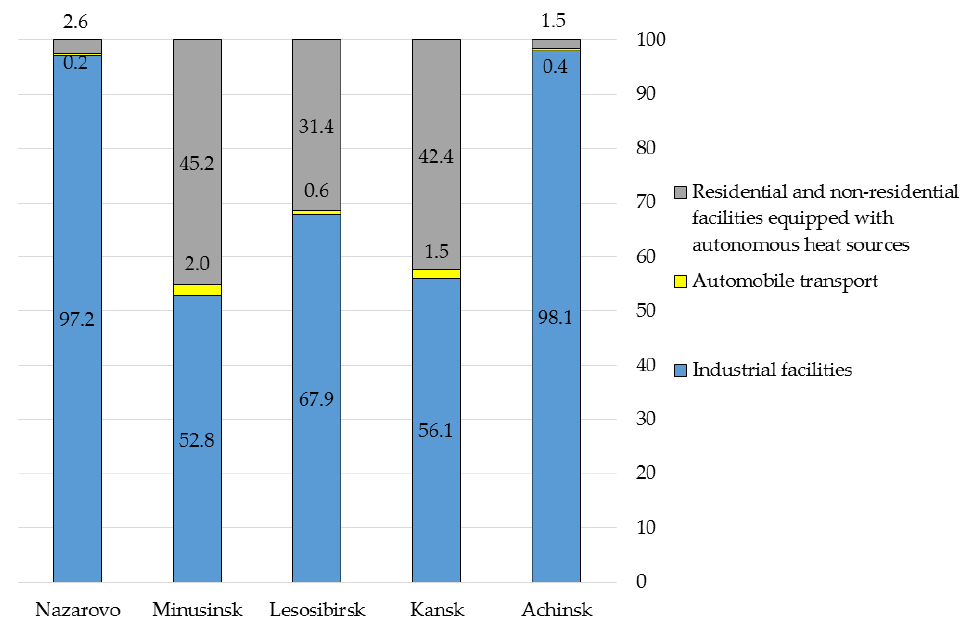
Figure 5. Structures of atmospheric air pollution in cities of Krasnoyarsk Krai by type of pollutants in 2020. Source: compiled according to the conclusions of the summary calculations of atmospheric air pollution in the cities of Krasnoyarsk Krai.